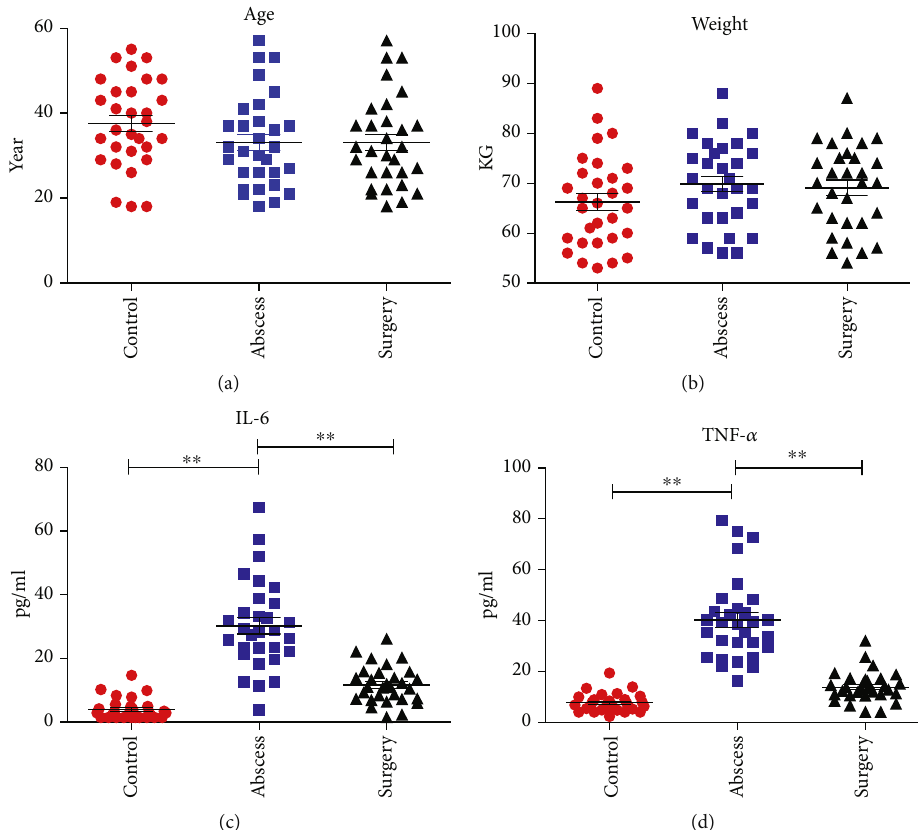
Figure 1: (a) Ages of the 30 healthy individuals and 30 patients with perianal abscess. (b) Weight of the 30 healthy individuals and 30 patients with perianal abscess. (c) Detection of IL-6 in blood samples. (d) Detection of TNF- α in blood samples. Wilcoxon test was used to test the signi fi cance of the di ff erences between the three groups. ∗ p < 0 : 05 , ∗∗ p < 0 : 01 .